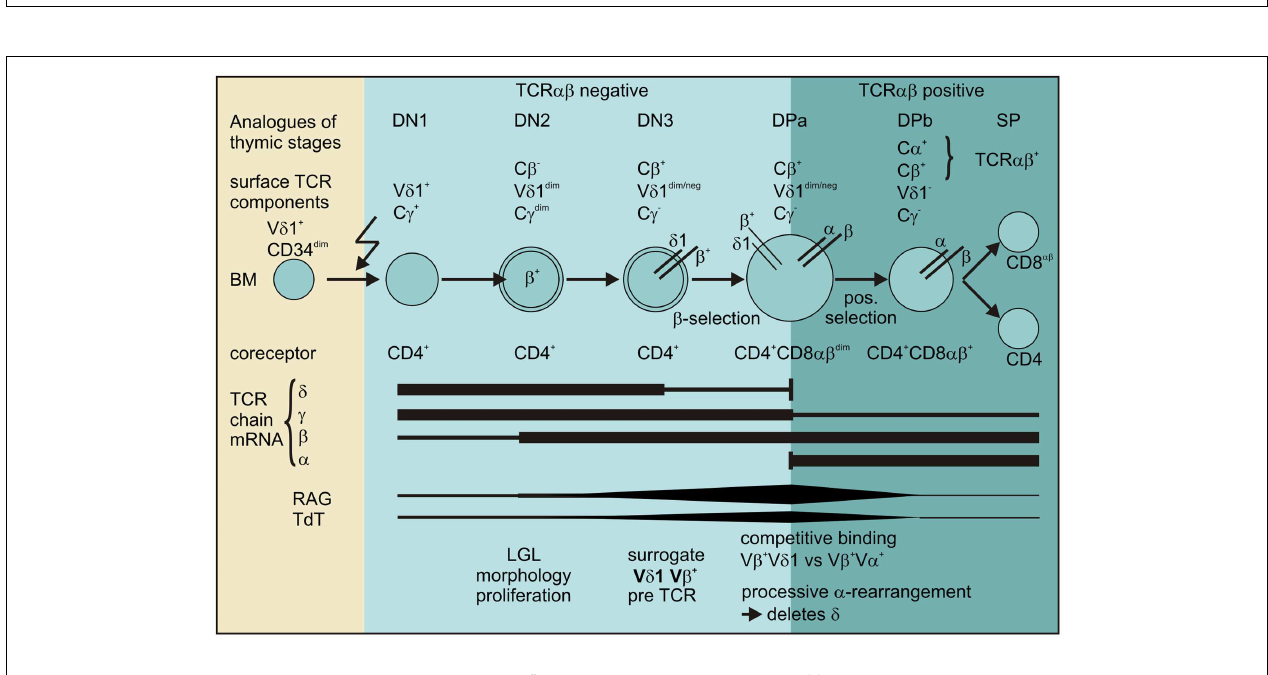
FIGURE 12 | Scheme for the transdifferentiation ofV δ 1 + CD34 dim precursors into αβ T cells inflammatory stimuli induceV δ 1 + CD34 dim precursors to move from the bone marrow into the periphery and express CD4 + . Chemokine receptors guideV δ 1 + CD4 + precursors to the sites of inflammation where inflammation-associated stimuli induce their development into αβ T cells:V δ 1 + CD4 + cells sequentially rearrange, transcribe and expressV β chain intracellularly, while downmodulating TCR γ and to a lesser extentV δ 1 expression.TheV β chains then appear